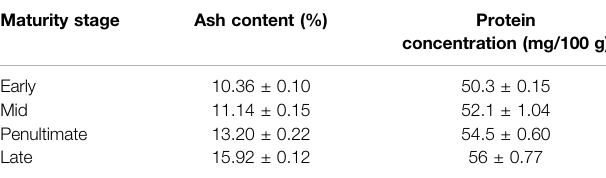
TABLE 3 | Ash and protein contents of M. oleifera leaf at different maturity stages.